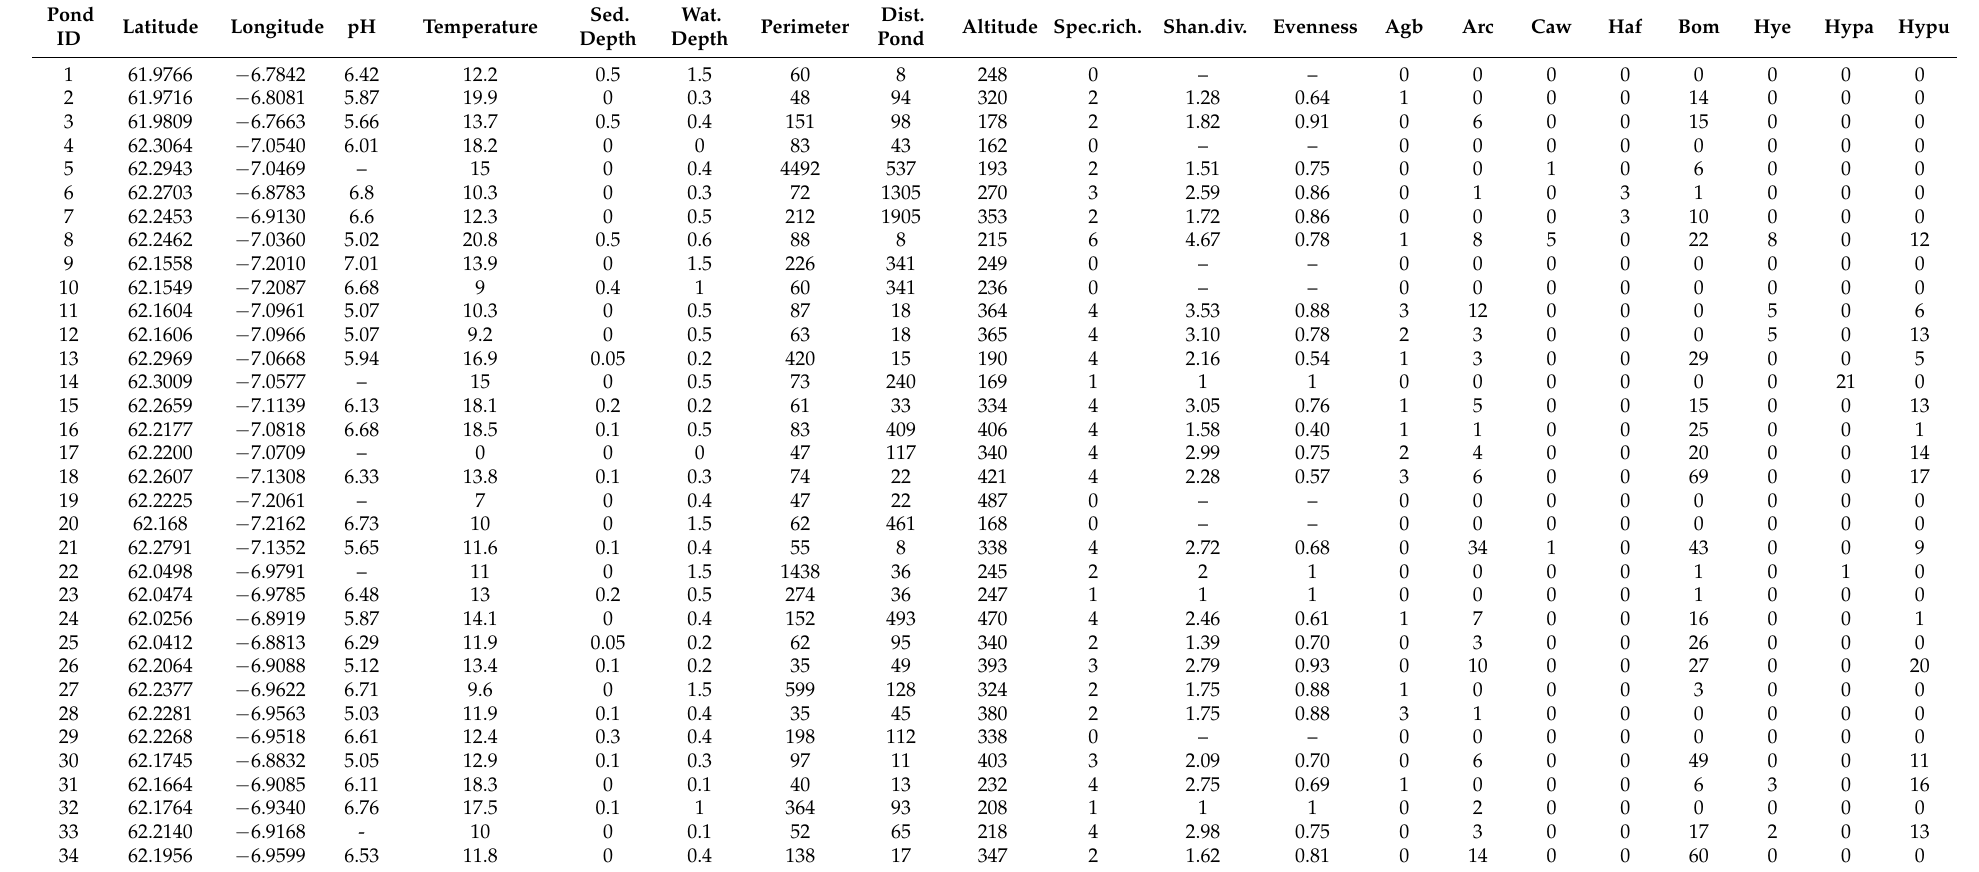
Table 1. Geographical location, environmental variables, diversity indices, and species abundances of the sampled ponds. Temperature is given in ◦ C, sediment depth (“Sed.depth”) and water depth (“Wat.depth”) in m, length of shoreline (“Perimeter”) in m, and altitude above sea level in m. The three different diversity indices used are species richness (“Spec.rich.”), Shannon diversity (“Shan.div.”), and Shannon evenness (“Evenness”). Number of water beetles and water boatmen in the pond samples are given, and the species are abbreviated with the following acronyms: Agb— Agabus bipustulatus , Arc— Arctocorisa carinata